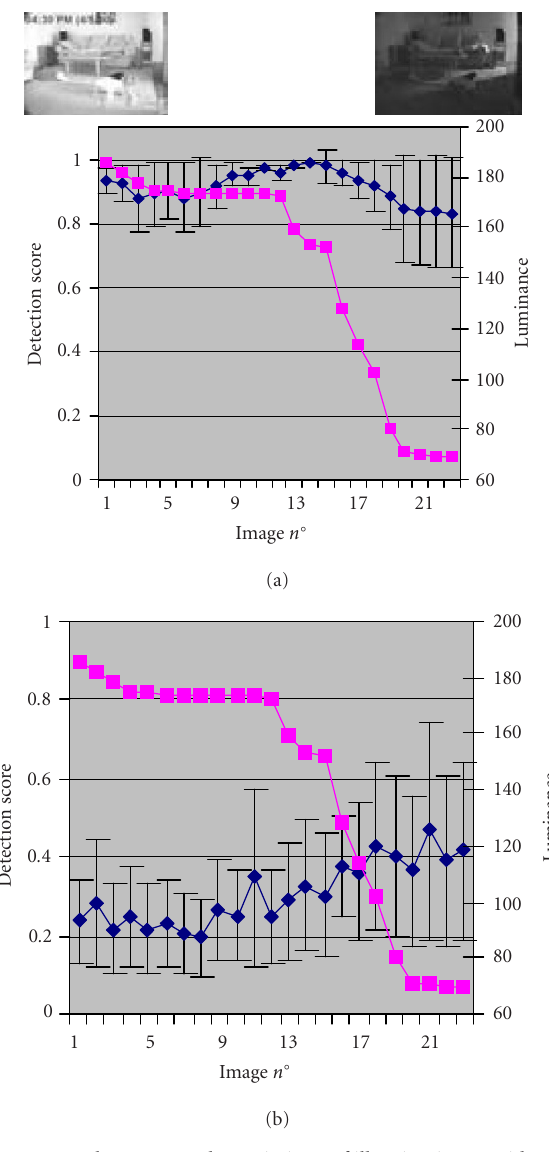
Figure 6: Robustness to the variations of illumination. A video se- quence with a continuous variation in luminance has been used to follow the detection of homologous interest points from image to image. The figure shows the mean detection score for (a) targets and (b) nontargets superimposed with the luminance curve (expressed in grey